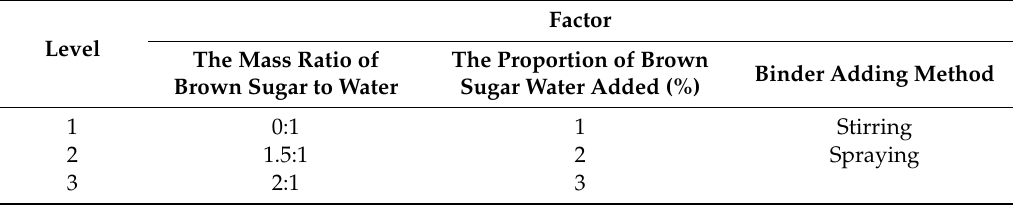
Table 1. Orthogonal test table of three factors mixed level.